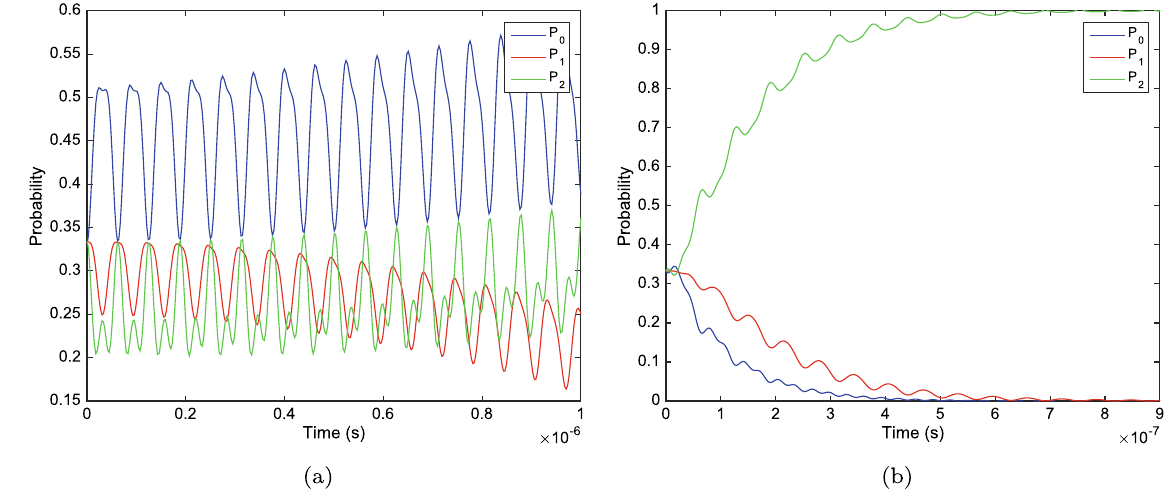
1 and ( a ) 1 10 8 s − = ×